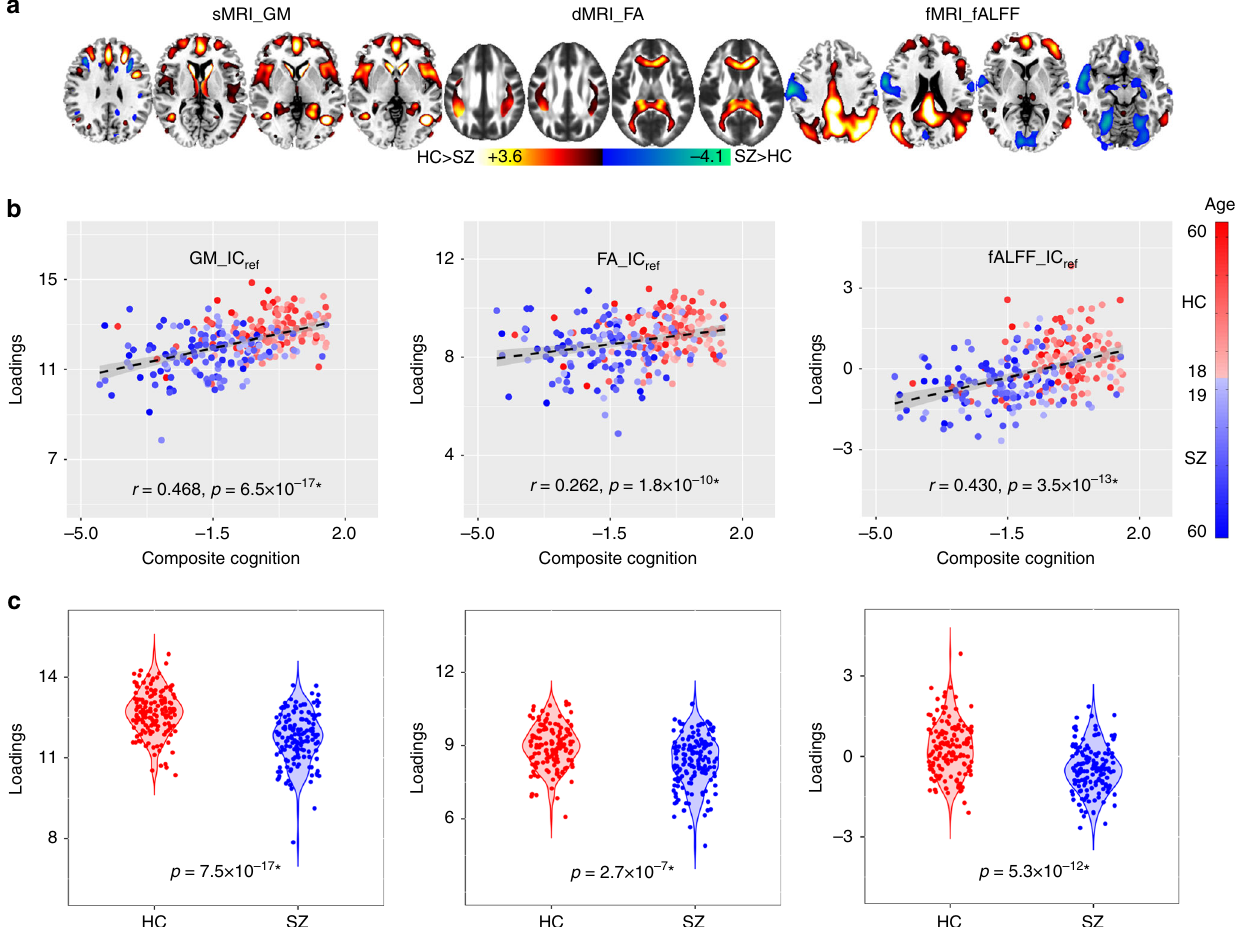
Fig. 1 The identi fi ed joint components for FBIRN cohort. a The brain maps visualized at | Z | > 2; the positive values (red) means SZ < HC and the negative values (blue) means SZ > HC. b Correlations between CMINDS composite scores and loadings of component (HC: the red dots, SZ: the blue dots); thus SZ corresponds to worse cognitive performance and lower loading weights compared to HC. c Boxplot of the loading parameters of FBIRN_IC ref_composite that were adjusted as HC > SZ on the mean of loadings for each modality, with two sample t -tests p values between HC and SZ shown bottom. The gray regions in b indicate a 95% con fi dence